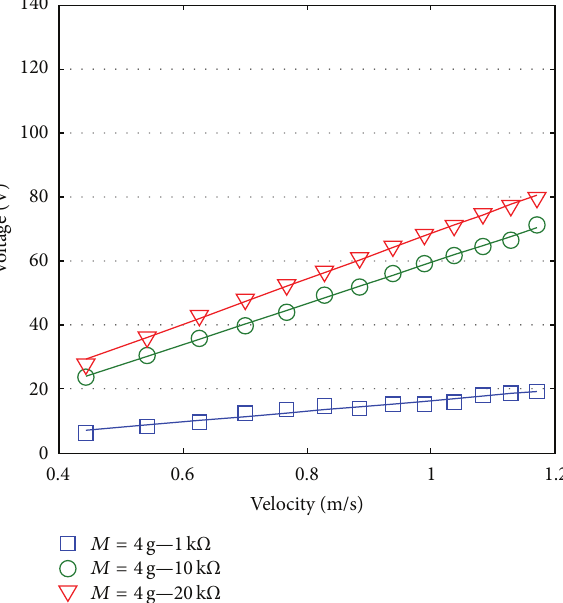
Figure 3: Instantaneous peak output voltage versus